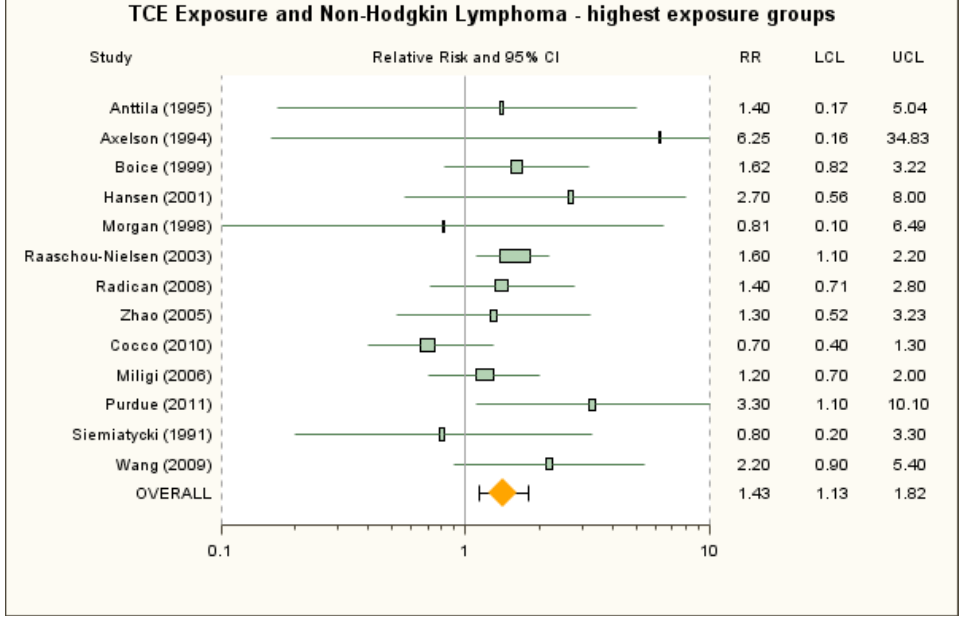
Figure 6. Forest plot of highest TCE exposure group and non-Hodgkin lymphoma from random-effects meta-analysis. Individual study results are plotted with 95% confidence intervals. Symbol sizes reflect relative weights of the 13 cohort and case-control